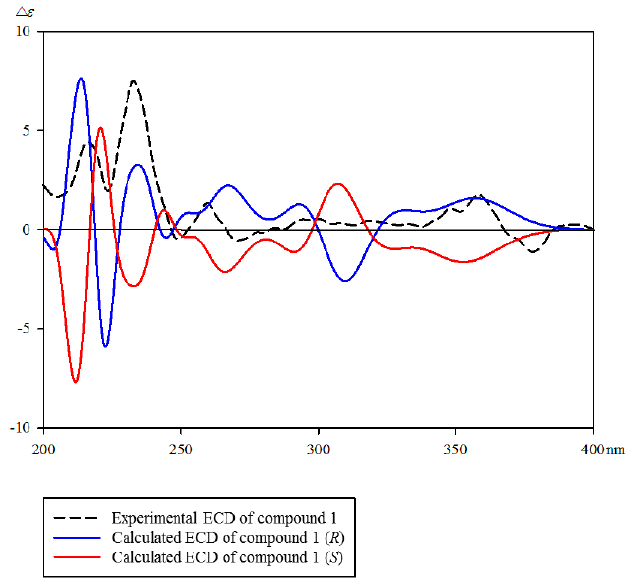
Figure 3. Experimental and calculated CD spectra of 1 .